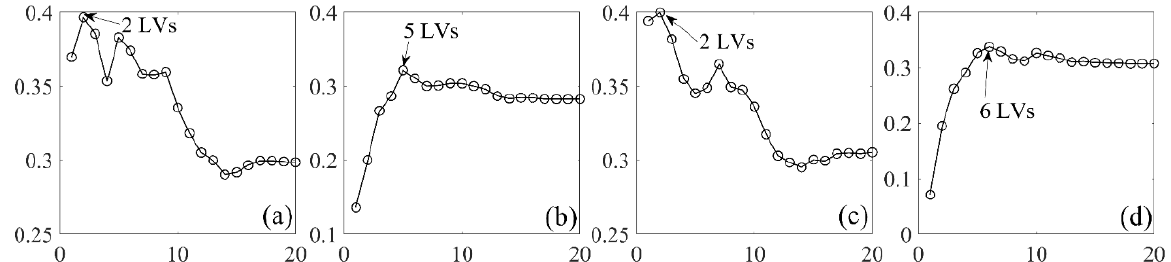
Figure 10. The RPR value of different number of LVs for 4 models with different forms of spectra: ( a ) indicates the model based on Spectral reflectance (R); ( b ) indicates the R’ model; ( c ) indicates the ln(1/R) model and ( d ) indicates the CR model. Axis X indicates the number of LVs for modelling. Axis Y indicates the RPR value.